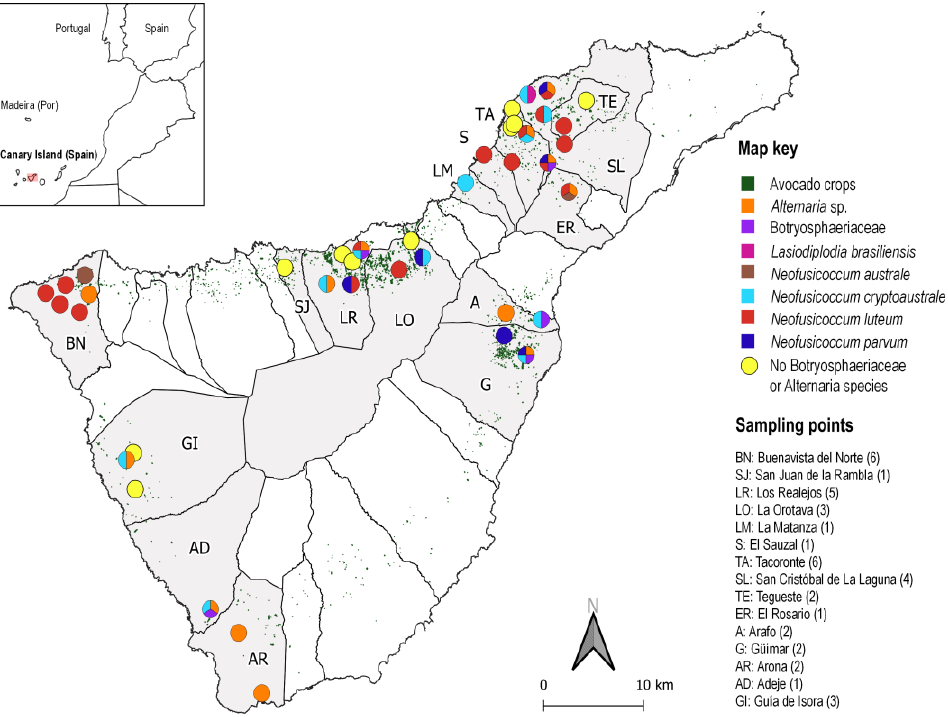
Figure 4. Map showing the sampling points and the species of fungi that were detected in Tenerife Island. Avocado plantations in the Canary Islands are highlighted in green. The map indicates the townships and the abbreviated names of places where samples were collected.